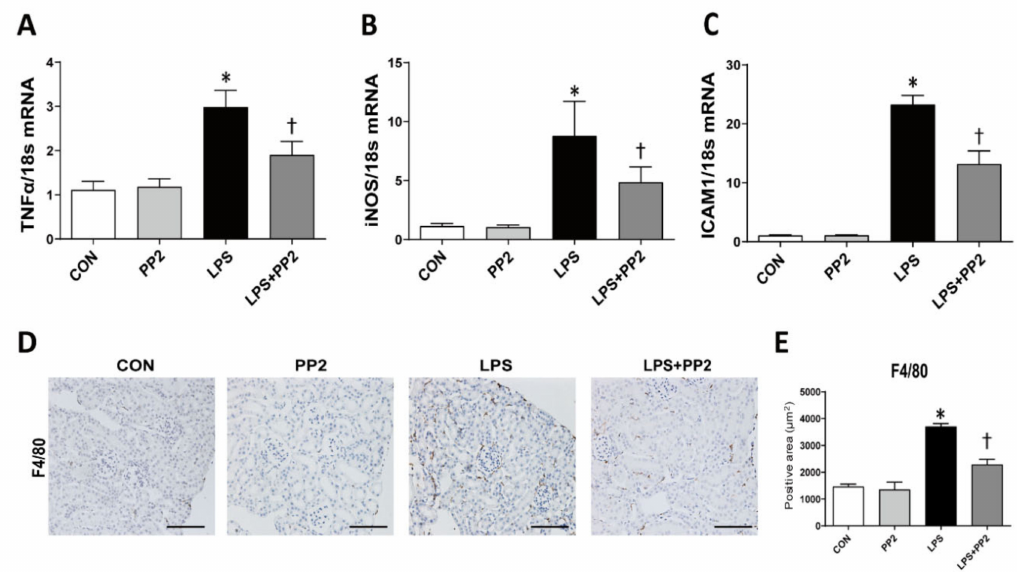
Figure 3. PP2 inhibits kidney inflammation in the LPS-induced AKI mice. ( A – C ) The mRNA levels of inflammation markers such as TNF- α , iNOS, and ICAM1 in kidney tissue were measured using real time RT-PCR analysis. The levels of mRNA were normalized with 18S. ( D , E ) Para ffi n-embedded kidney sections were stained with anti-F4 / 80 antibody (1:400; original magnification: 200 × ; scale bar: 100 µ m). Data are presented as mean ± SE of 6–8 mice. * p < 0.05 vs. control, † p < 0.05 vs.